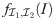
Stereotypical active response.(A) Paused template velocities. Error bars show the standard deviation of the template. Models are estimated separately for the three different worm types, indicated by different colors. Time t = 1 s corresponds to the moment of the stimulus application. (B) Normalized active template velocity. Each template velocity is normalized by the absolute value of its minimum | mint
va |. The error bars represent the model standard deviation, estimated by bootstrapping (Materials and Methods). The subfigure shows the template velocities adjusted by the time of maximum reverse velocity, illustrating that the three templates nearly match. (C) The rescaling function fI1,I2(I) for the three different worm types, normalized by multiplying by the absolute value of the minimum of the active template velocity | mint
va |. The optimized parameter values are I1=-4.5,-4.5,66.5 and I2=45.0,12.0,∞ for the control, ibuprofen, and mutant worms, respectively. We deliberately do not report error bars on individual parameters, but rather show the one standard deviation confidence intervals for the entire rescaling curve as shaded regions on the figure. The confidence region was again estimated using bootstrapping.